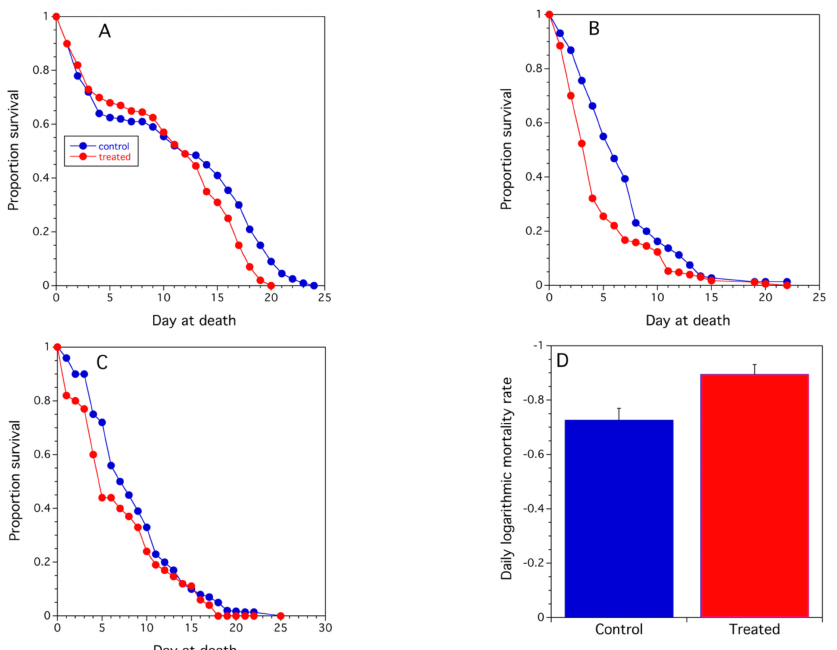
Figure 8. Longevity of worker honey bees measured in proportion bees surviving per day, 2011 ( A ), 2012 ( B ), 2013 ( C ). Average daily logarithmic (base 10) mortality rate, error bars are standard errors of the mean ( D ).